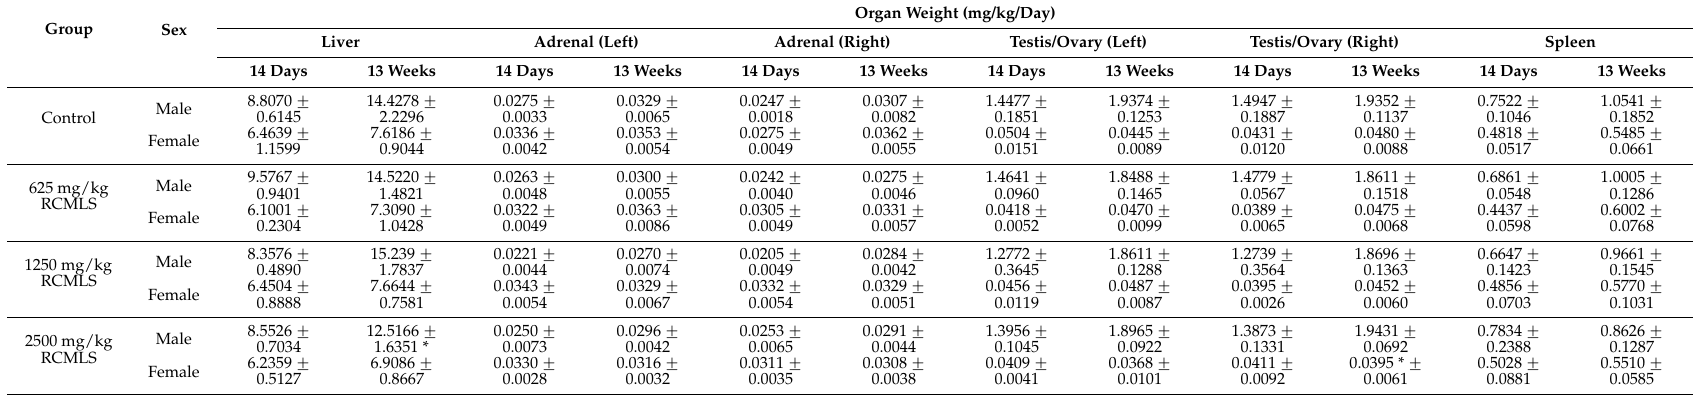
Table 9. Absolute organ weights of male and female rats in 14 days repeated oral dose and 13 weeks repeated oral dose toxicity studies of the leaves and stems of Rubus coreanus Miquel.